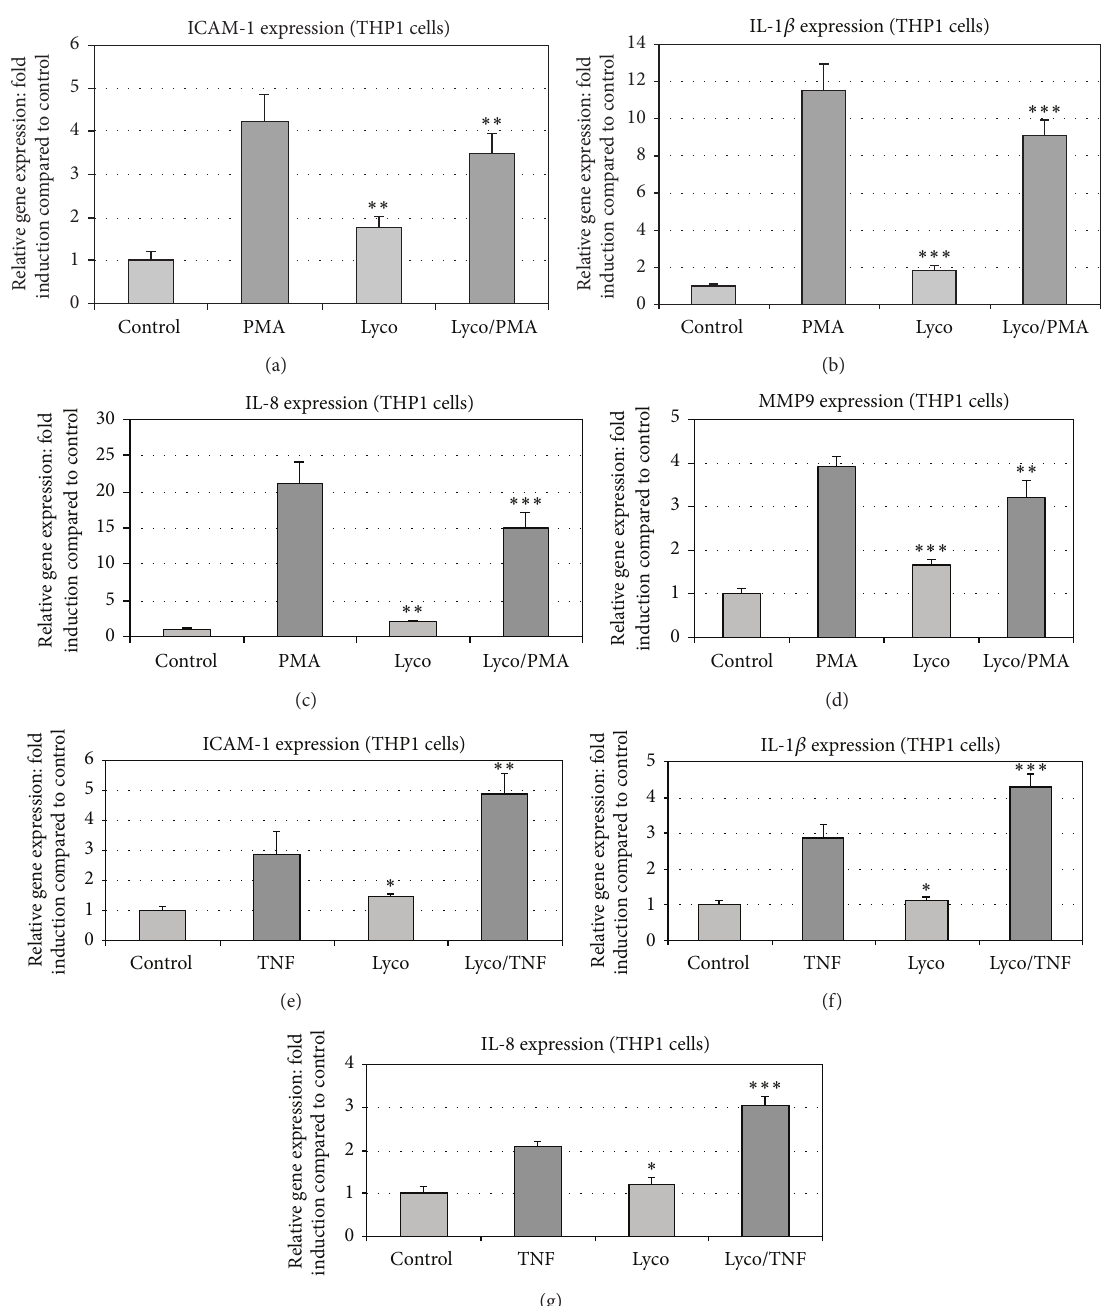
Figure 2: Lycopene modulates gene expression induced by PMA and TNF in THP1 cells. ICAM-1 ((a), (e)), IL-1 𝛽 ((b), (f)), IL-8 ((c), (g)), and MMP9 (d) gene expression was studied in THP1 cells treated with either PMA (a,b,c, and d) or TNF 𝛼 ((e), (f), and (g)). Modulation of this expression was studied in THP1 cell cultures pretreated for 2 h with or without Lycopene (2 𝜇 M). Then, according to assays, PMA (100nM) or TNF 𝛼 (10ng/mL) was added for 6 h and mRNA expression was analyzed by RT-qPCR. Values are means ± SD ( 𝑛 = 8 ). Assays treated with lycopene were compared to corresponding assays without lycopene. ∗∗∗ 𝑃 < 0.01 ; ∗∗ 𝑃 < 0.05 ; ∗ , nonsignificantly